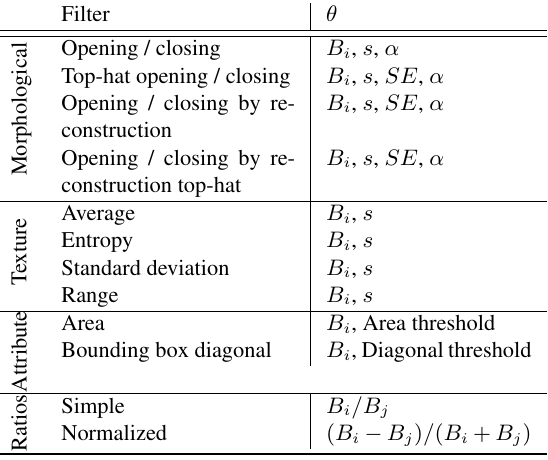
Figure 4: Houston 2013.(a) RGB composition of the CASI data, (b) DSM issued from the LiDAR point cloud and (c) ground truth. (for color legend, see Tab. 2). Unlabeled samples are in black. Table 4: Filters considered in the experiments ( B i , B j : input bands indices ( i, j ∈ [1 , . . . b ] ); s : size of moving window, SE : type of structuring element; α :